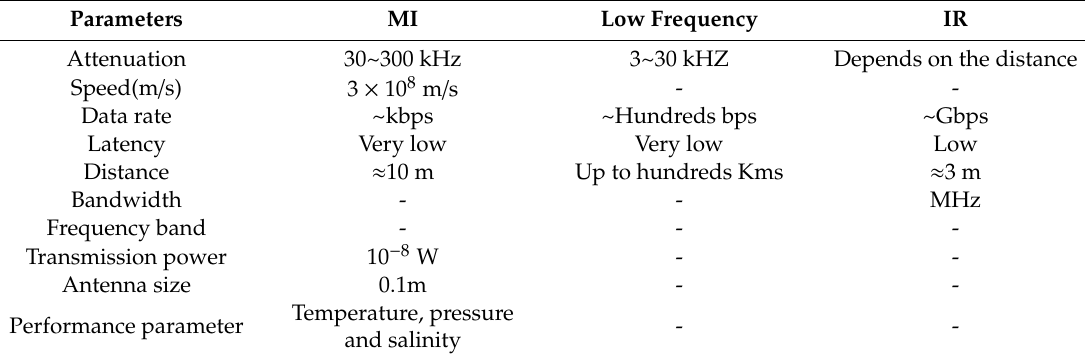
Table 2. Comparison of di ff erent communication technologies in